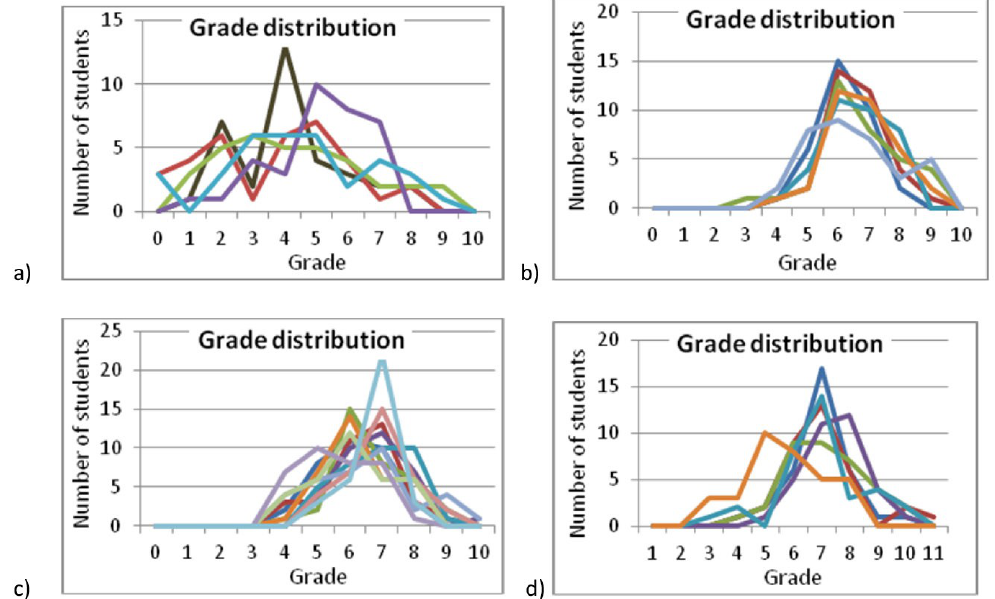
Figure 7. Distributon of the grades assigned to each explanaton. a) Large spread of scores, b), c) and d) Higher or lower